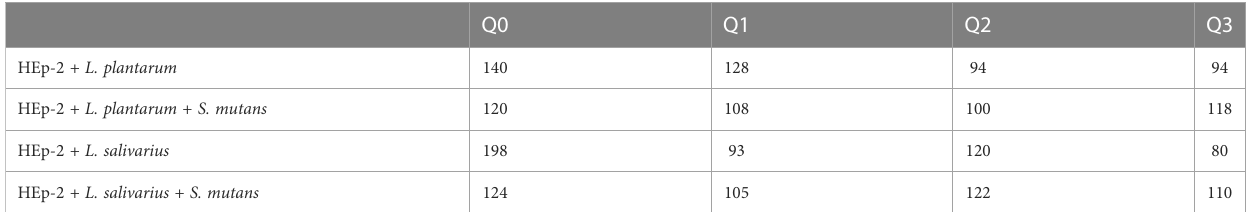
TABLE 3 Probiotic